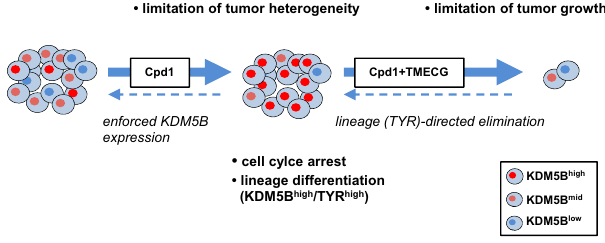
Fig. 7 Phenotype-speci fi c dual hit strategy in melanoma. KDM5B persister state-directed transitioning limits tumor plasticity and heterogeneity and primes melanoma cells towards lineage-speci fi c